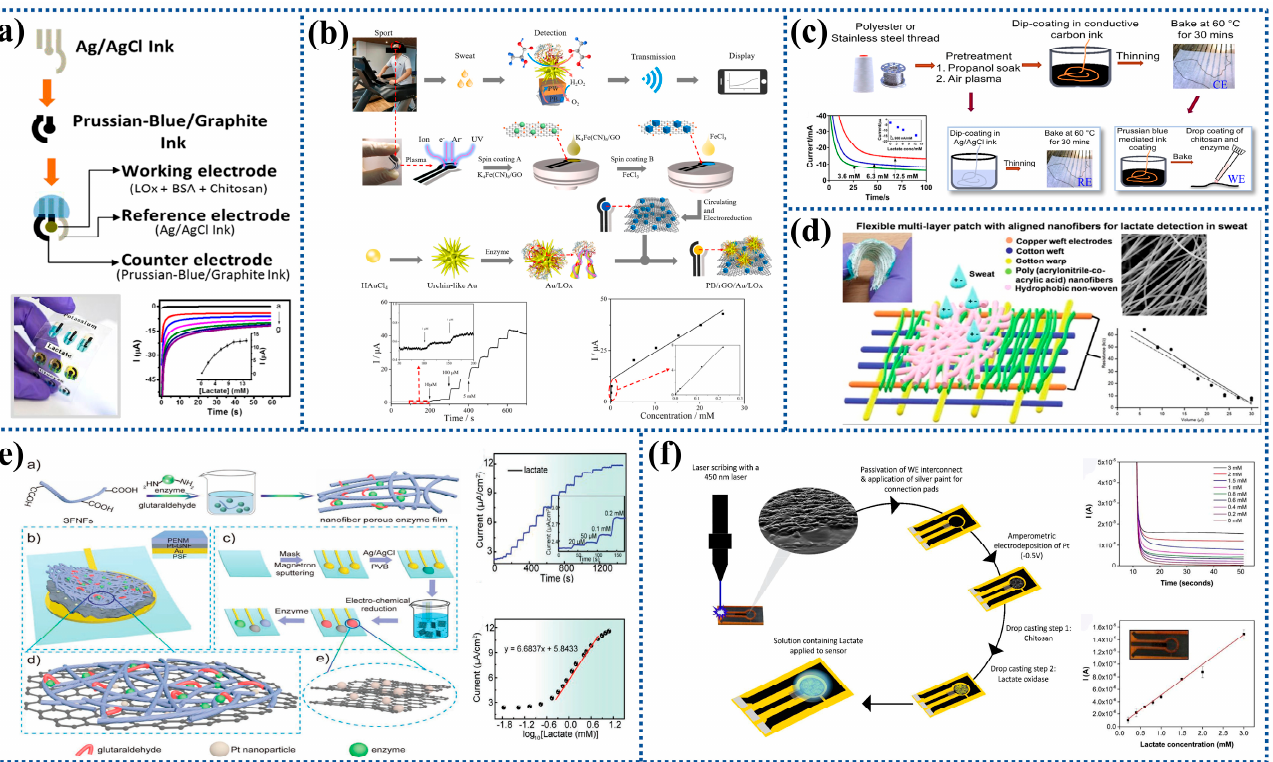
Figure 3. Preparation process and characterization of electrochemical biosensors for lactate detection: ( a ) A fully integrated wireless eyeglasses − based biosensor platform for monitoring lactate in sweat in real time. Reprinted with permission from ref. [40]. Copyright 2017 Royal Society of Chemistry. ( b ) A wearable lactate biosensor fabricated by in − situ preparation of PB sensing membrane incorporated with rGO and urchin − like Au NPs on flexible SPCE. Reprinted with permission from